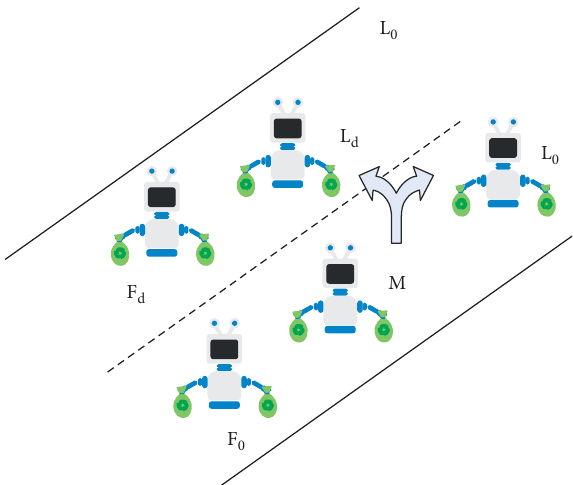
Figure 4: Schematic diagram of the surrounding robots at the time of lane change.